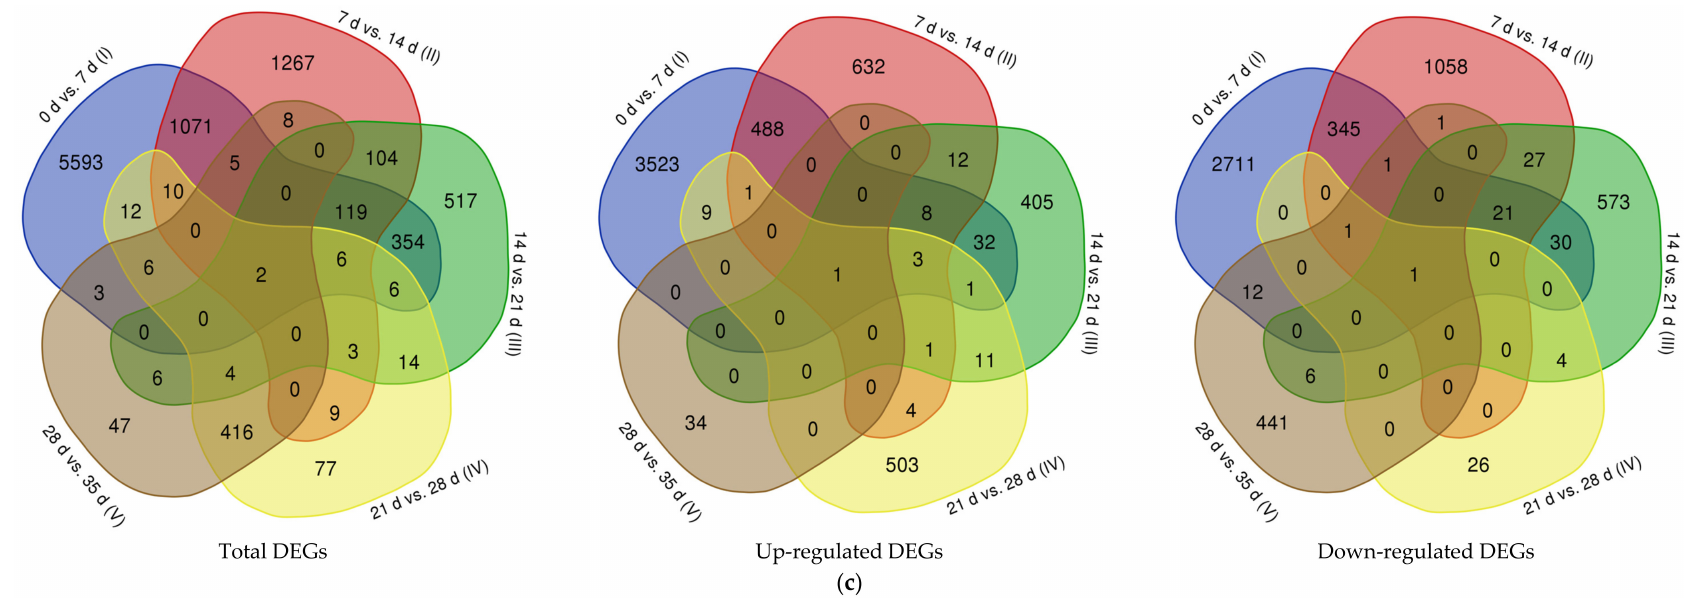
Figure 3. The number of differentially expressed genes (DEGs) in five stages of cold-stored loquat fruits. ( a ) Volcano plots illustrated the expression patterns of DEGs in different stages; red spots were up-regulated DEGs and green spots were down-regulated DEGs; ( b ) Barchart showed the number of DEGs detected in different stages; ( c ) Venn programs exhibited the overlapped DEGs among different